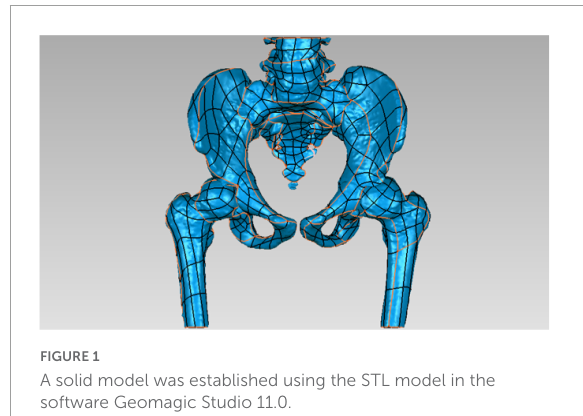
FIGURE1 A solid model was established using the STL model in the software Geomagic Studio 11.0.